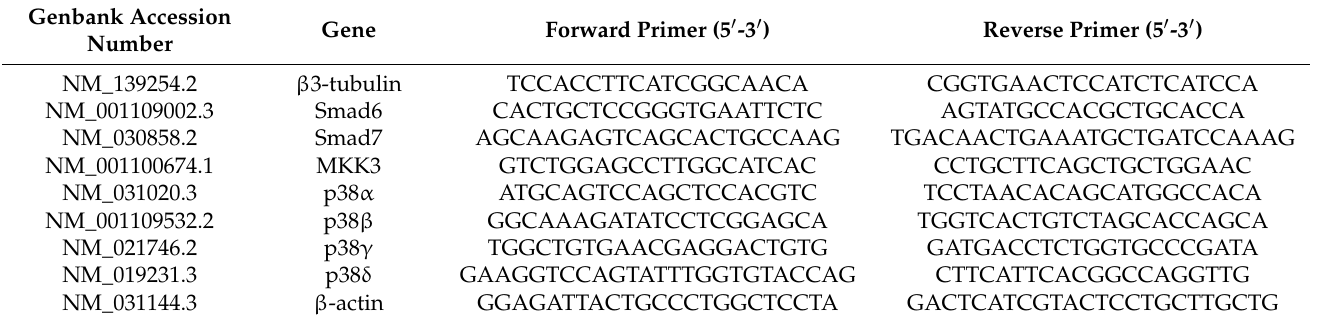
Table 1. Primer sequences for quantitative real-time polymerase chain reaction